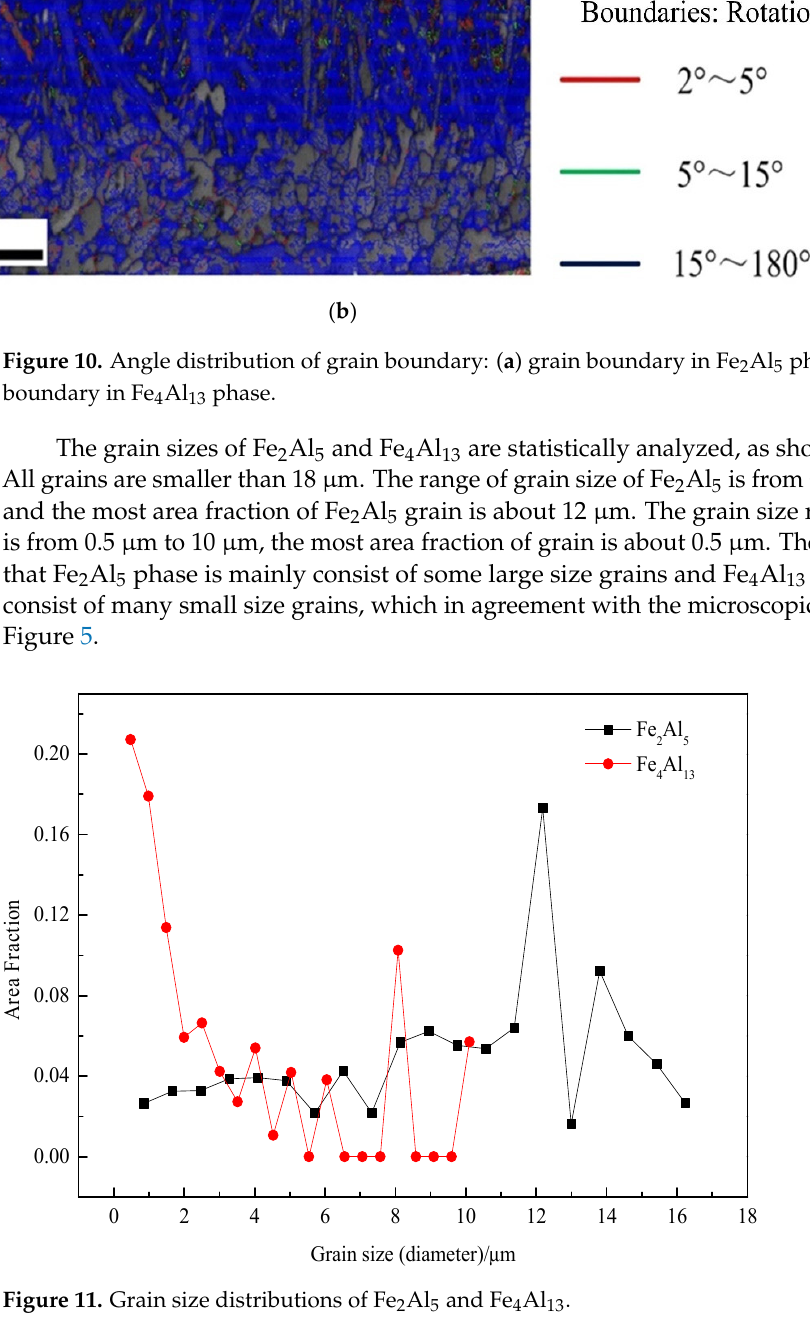
Figure 11. Grain size distributions of Fe 2 Al 5 and Fe 4 Al 13 .